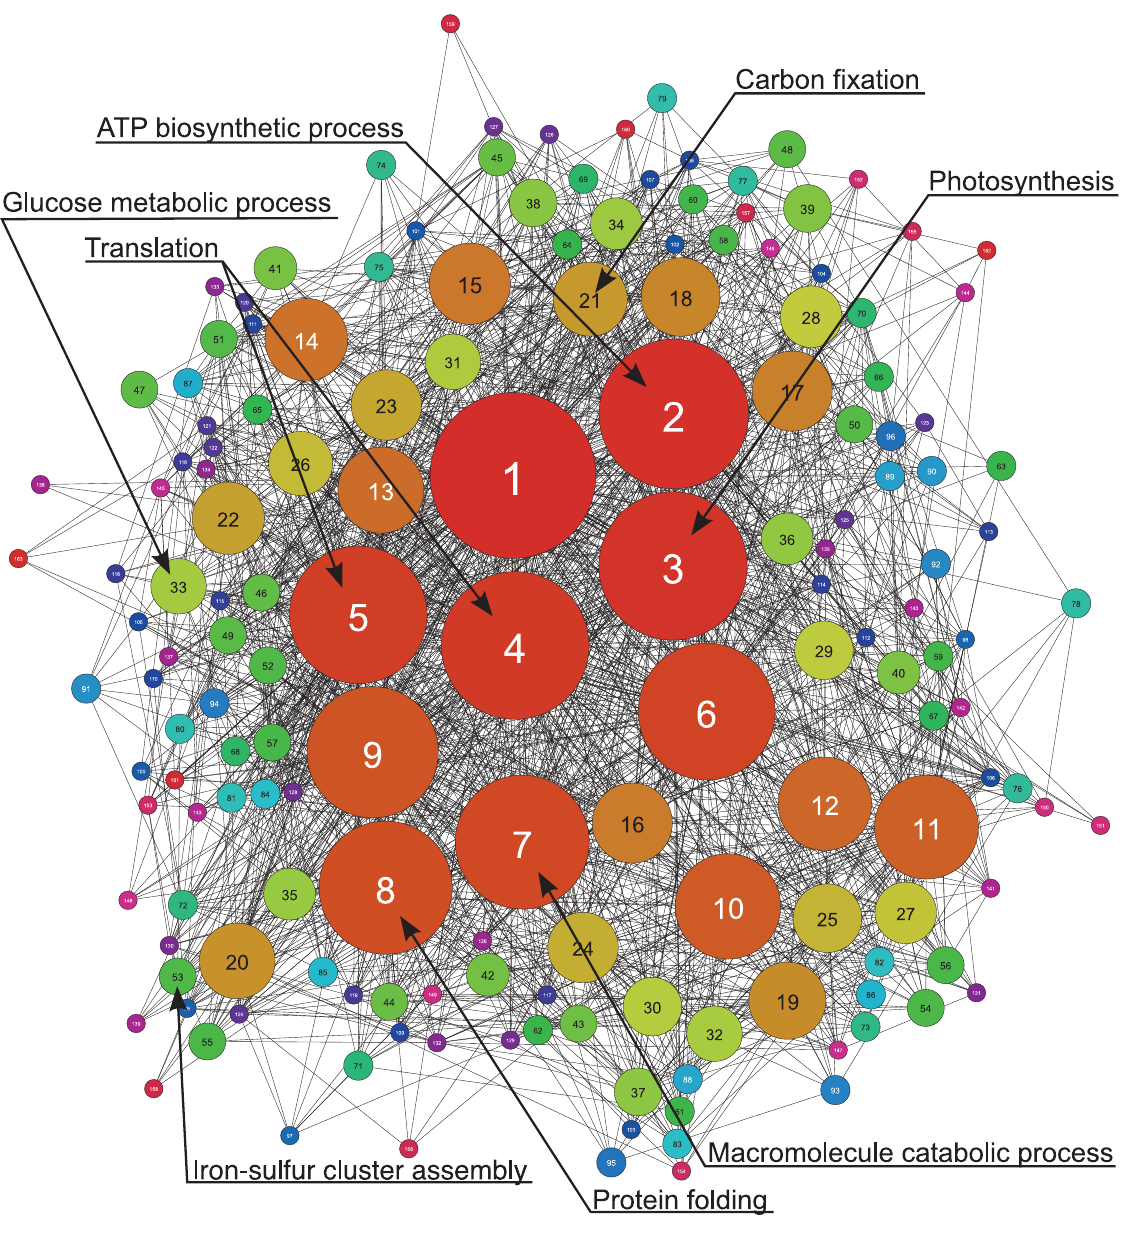
Figure 2. Clustered co-expression network. A clustered co-expression network derived from the complete co-expression network at a CLR threshold of 4.0. Each node corresponds to a set of clustered genes. The size of the nodes is proportional to the number of genes in the cluster. Two clusters are linked if they share at least one co-expressed gene pair. The annotations correspond to the most significantly enriched GO terms in the clusters ( q ,